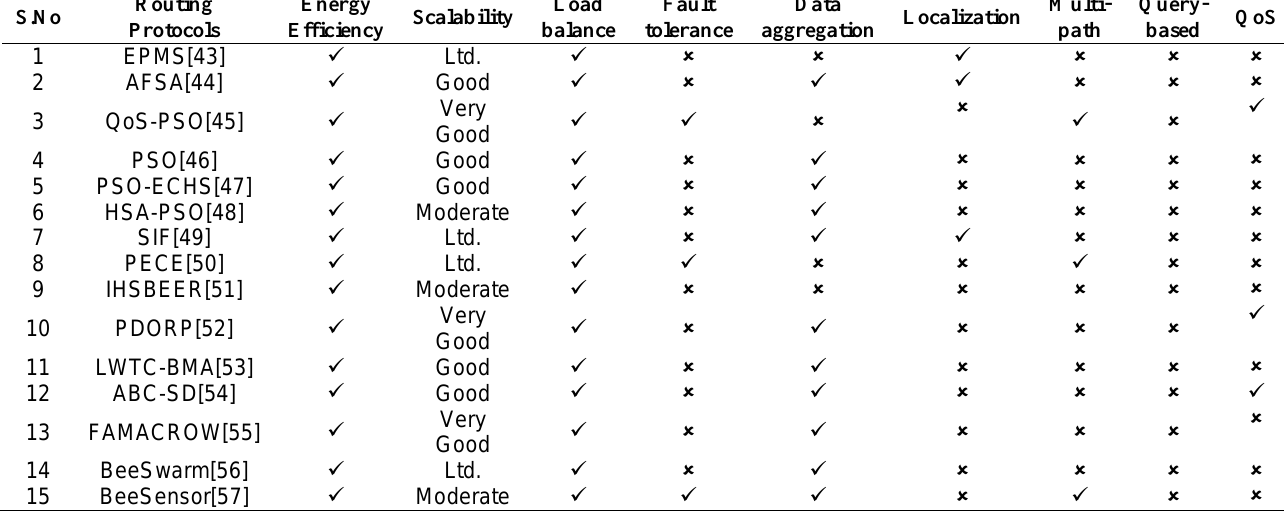
Table 5. Classification of swarm intelligence based routing protocols